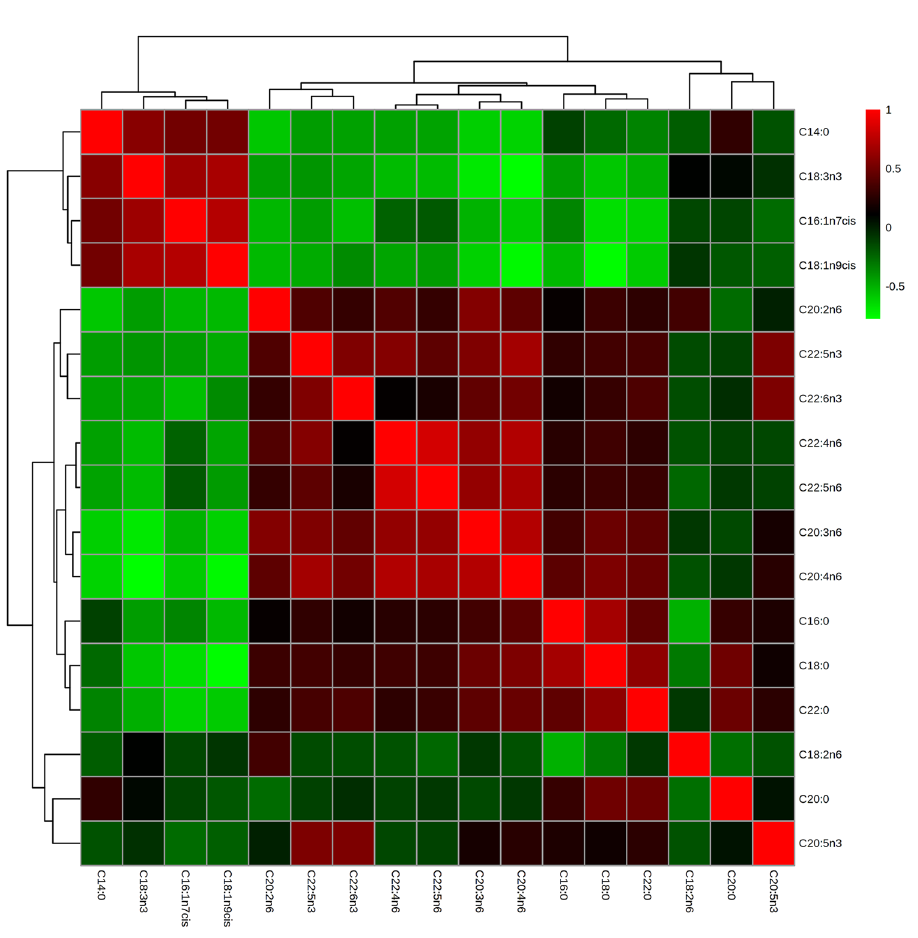
Figure 3. Spearman correlation coefficients in all available fatty acid species in serum